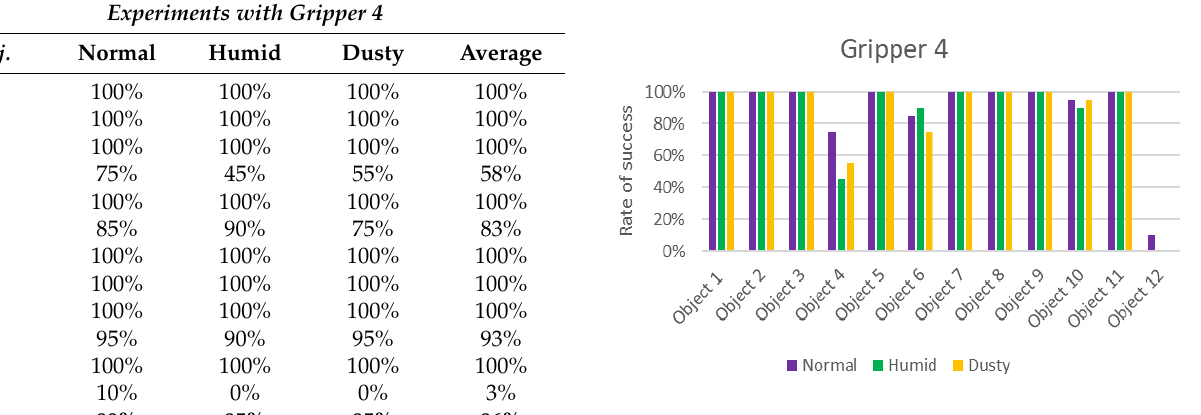
Experiments with Gripper 4